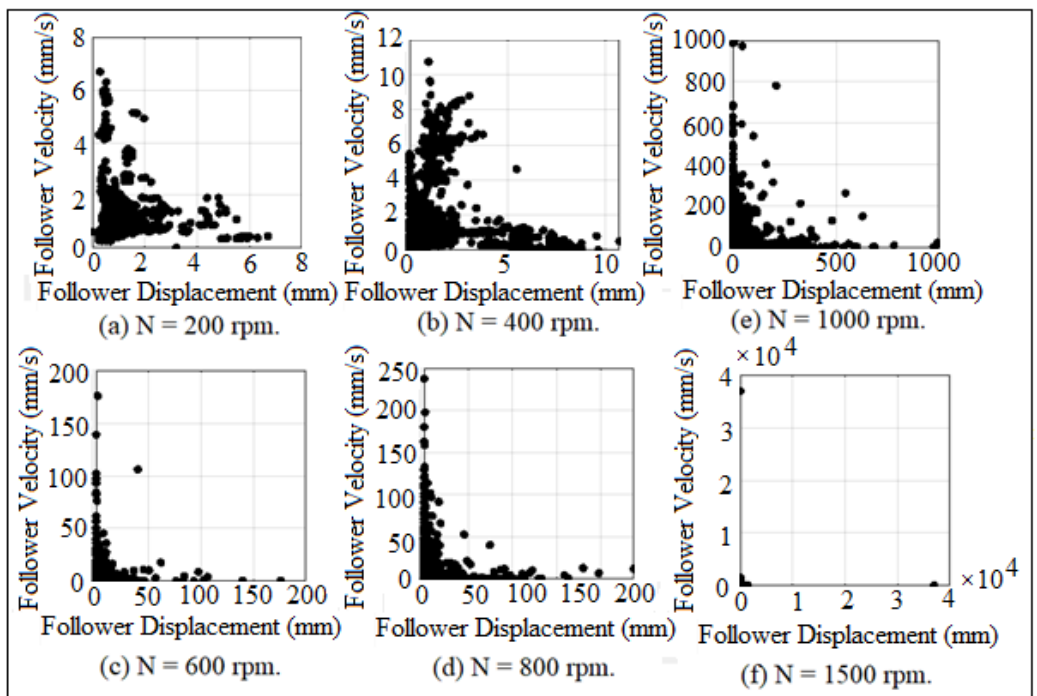
Figure 27. Poincare’ maps for (I.D. = 18 mm) at different cam speeds. Phase-plane diagram works alongside with Poincare’ map to check for periodic and non-periodic motion of the follower movement. When the orbit of the follower movement is one closed curve which indicated to periodic motion but when the orbit of the follower movement diverges with no limits of spiral open cycles, it gives indication to non-periodic motion and chaos. Figure 28 showed the mapping of phase-plane diagram after using different values of coefficient of restitution at (I.D. = 19 mm) and (N = 200 rpm). The broken